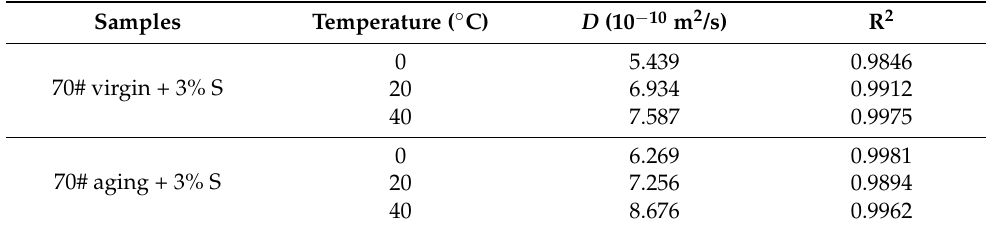
Table 4. Diffusion rate of sunflower oil in the virgin and aged asphalt at different temperatures.